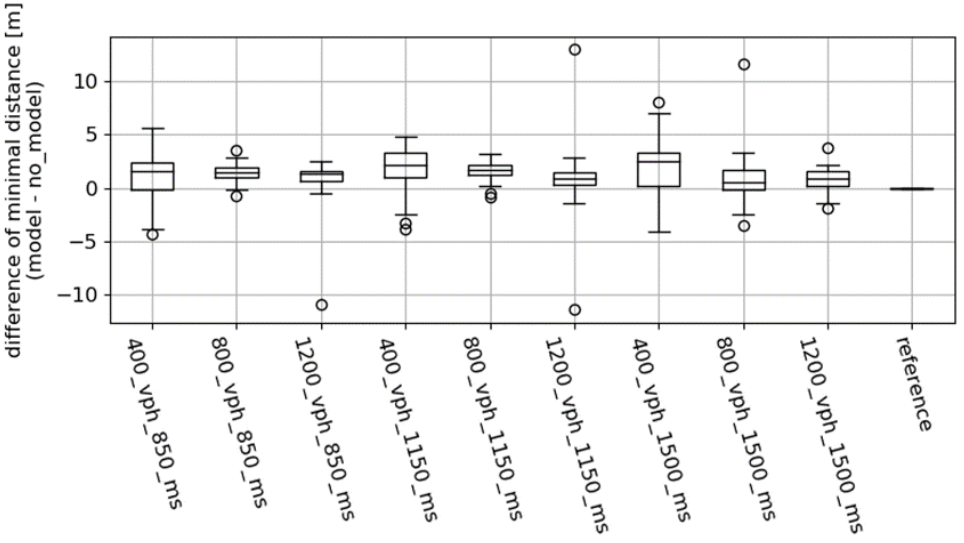
Figure 4. Boxplot visualization illustrates increase in the vehicles’ minimal distance for each simulation scenario.